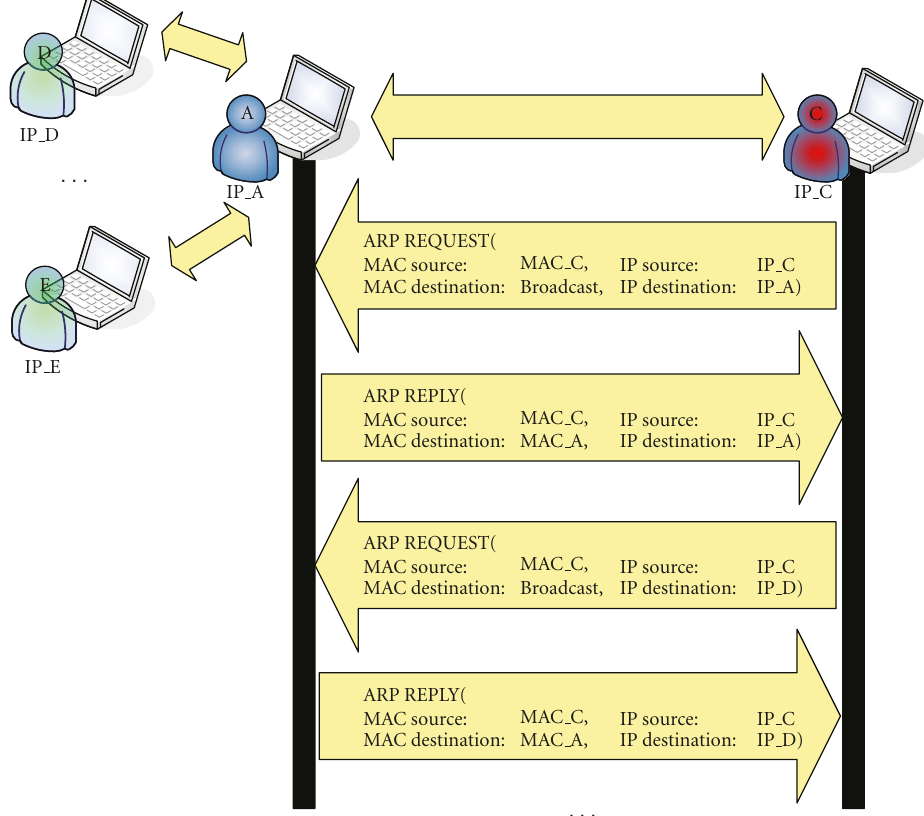
Figure 5: Attack to HOP attempting to disclose hidden pseudonyms through ARP queries.